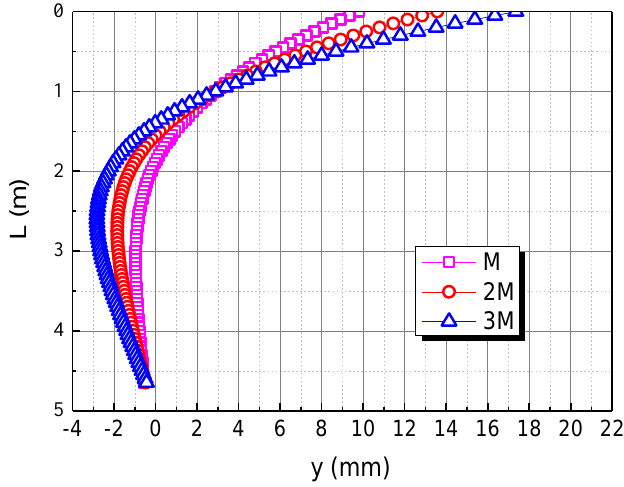
Figure 10. Effect of bending moment on horizontal displacement of pile in calcareous sand area.